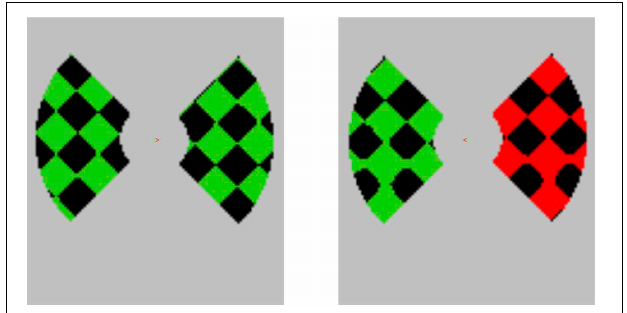
Transient color change on right hemifield, and a target check-size change is also shown in both hemifields in the lower quadrant. Upper vs. lower location was random and independent for each hemifield, and participants had to indicate the location of the target in the cued hemifield (here on the bottom